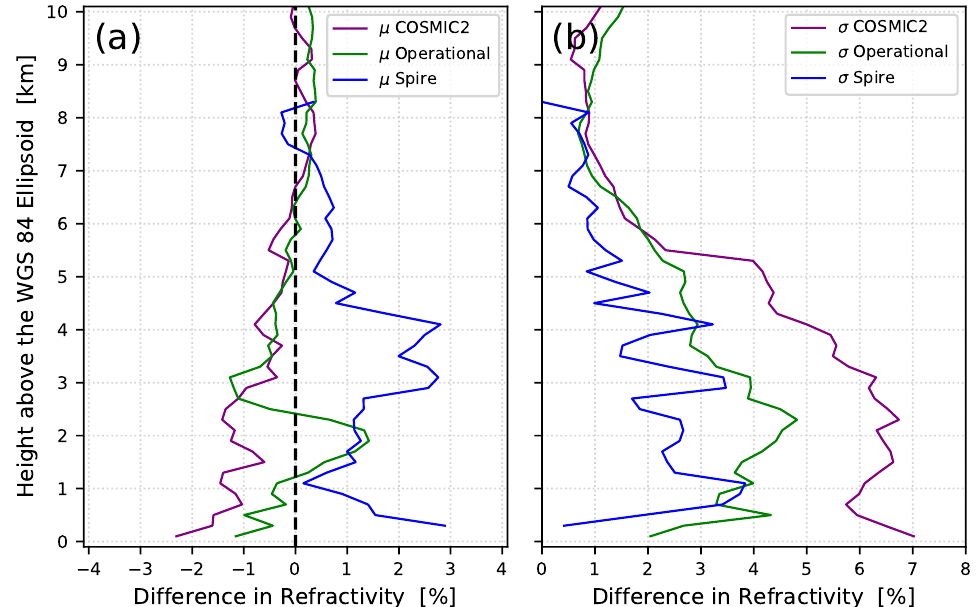
Figure 6. Comparison of the ( a ) mean and ( b ) standard deviation of the percent difference in refractivity between each of the observed datasets and their nearest AR Recon dropsonde that was within a distance threshold of 300 km and a time threshold of 2 h. The operational (green lines), COSMIC-2 (purple lines), and Spire (blue lines) datasets are shown. The thick dashed black line in panel ( a ) highlights the line of zero